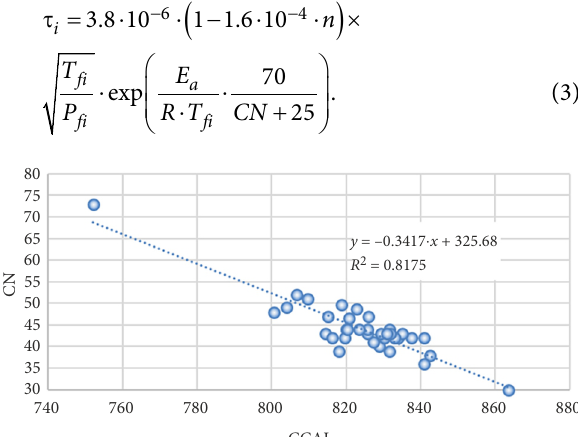
Figure 3. SKL VDS 48/42 experimental data and MM specific fuel consumption b e , exhaust gas temperature T , and mean effective pressure P me readings Figure 4. Relationship between CN and